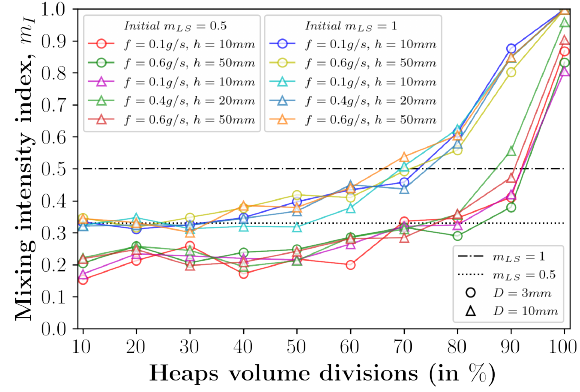
Figure 5. Mixing state computation across 3D granular deposits, heaps are divided in ten vertical stripes of same volume along its length. m I gradations corresponding to mixtures initial m LS are indicated as horizontal